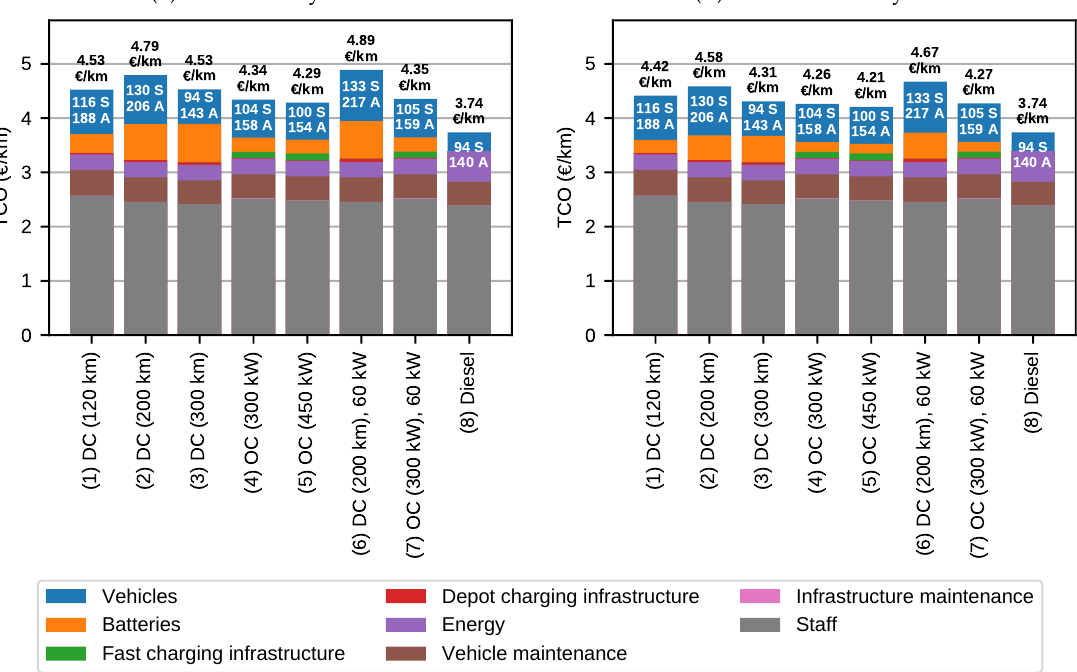
Figure 14. TCO results for all scenarios. S: standard bus; A: articulated